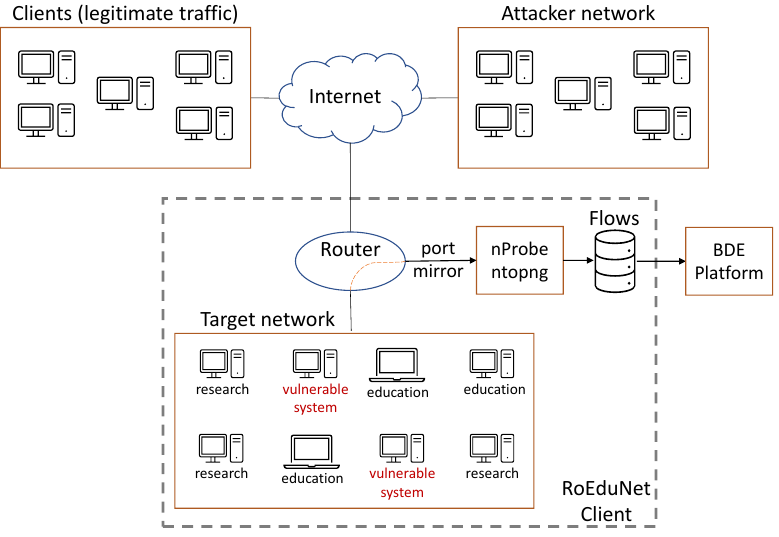
Figure 1. Network architecture for the “Reconnaissance and Denial-of-Service